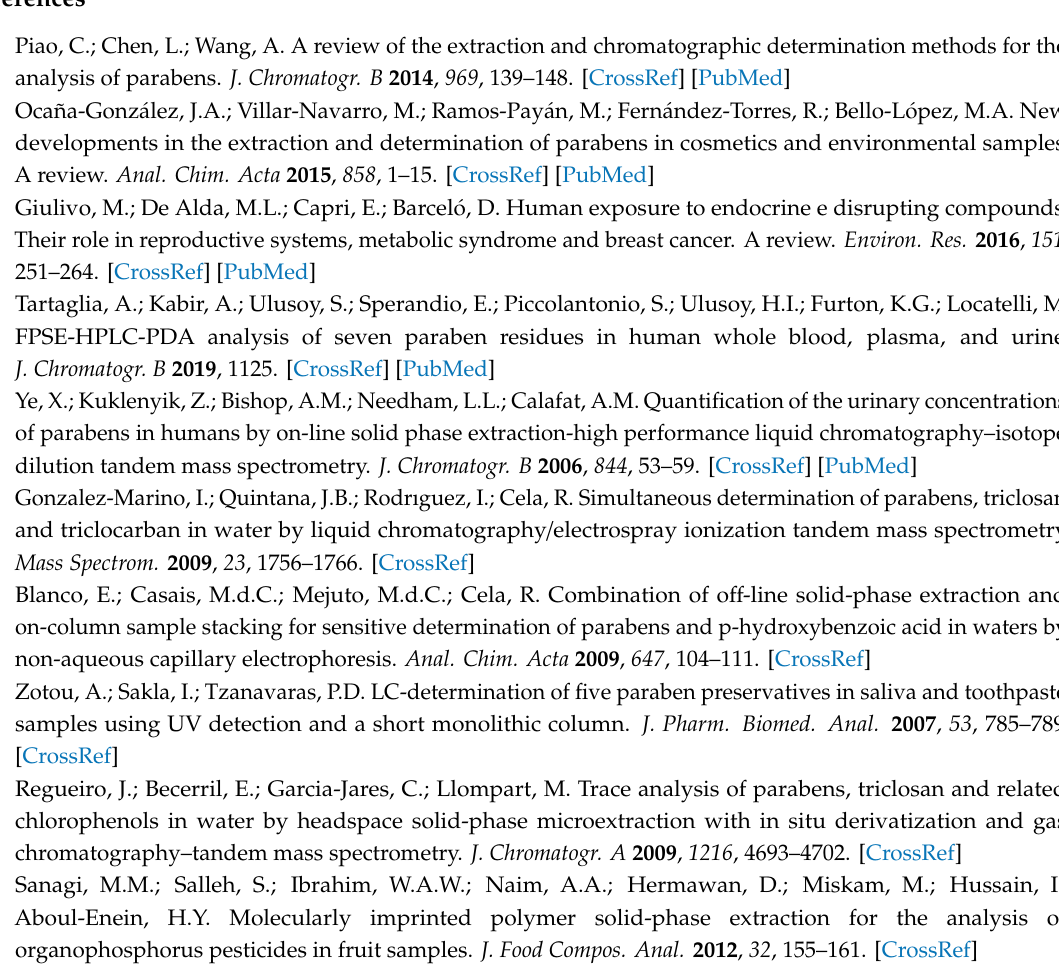
Figure S.1.1. Boltzmann’s functions for single parabens., Figure S.1.2. Selectivity of each paraben., Figure S.1.3. Chemical structures of a. Propyl paraben; b. iso –Butyl paraben; c. Butyl paraben; d. Benzyl paraben. All the axes report the concentration values ( µ g /